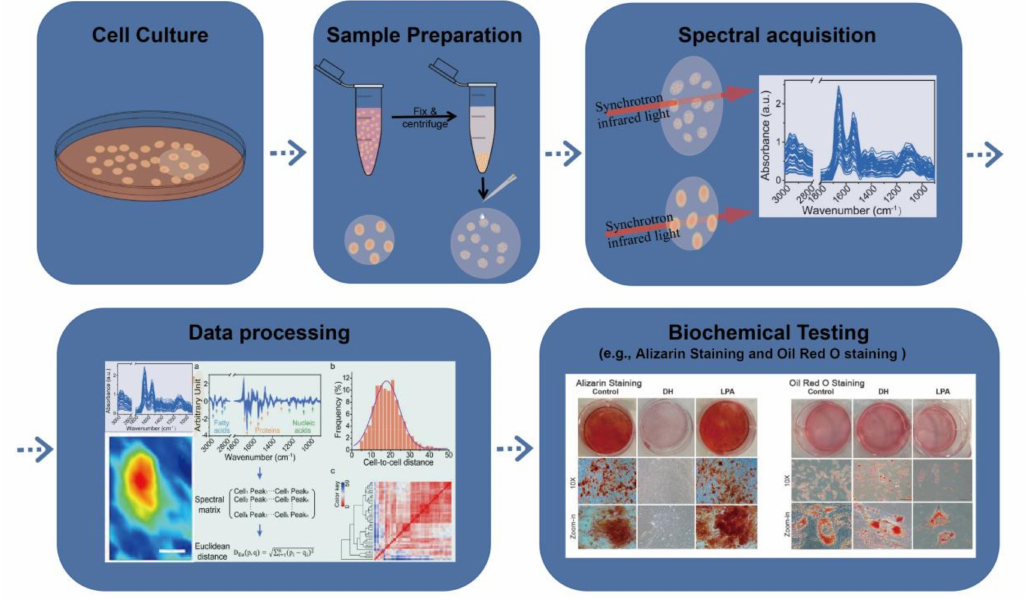
Figure 1. A representative workflow for SR-FTIR study of stem cells [11,17]. The Figure in “Spectral acquisition” was reproduced from Figure 1b in reference [11], Figures of “Data processing” were reproduced from Figure 1a and Figure 2a–c in reference [11]. The small Figures in “Biochemical testing” were reproduced from Figure 3a,c in reference